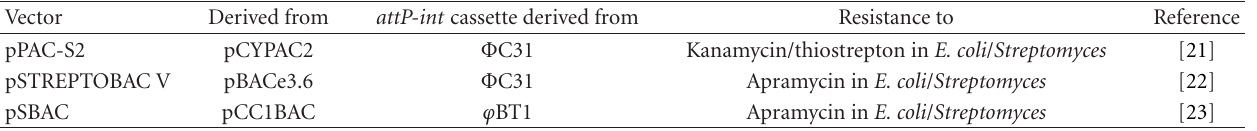
Table 1: Shuttle E. coli-Streptomyces artificial chromosomes.